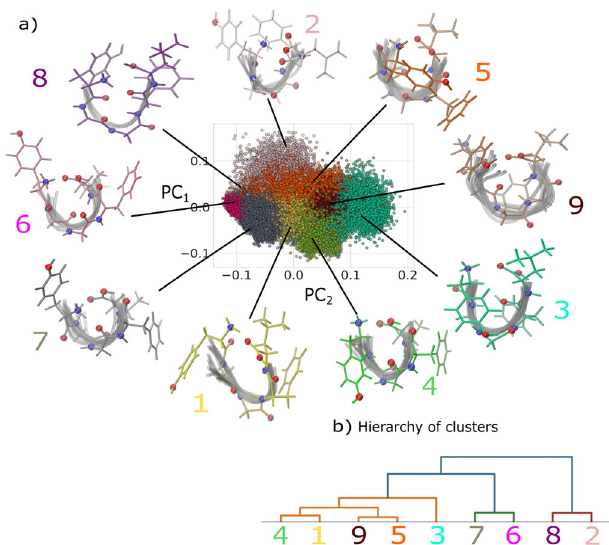
Fig. 2 Hydrogen-bonding statistics of LeuEnk from the REMD trajectory at 300 K. Probability distributions have been smoothed with triangular kernel of width 0.025 and are represented in terms of F ¼ (cid:2) k B T ln ð P Þ , expressed in kcal/mol. We also report the integrated (joint) probabilities (in percent) for the corresponding region of different integer values of s A , s s D , and H . Schematic representations of two exemplary H-bonding con fi gurations are given in the